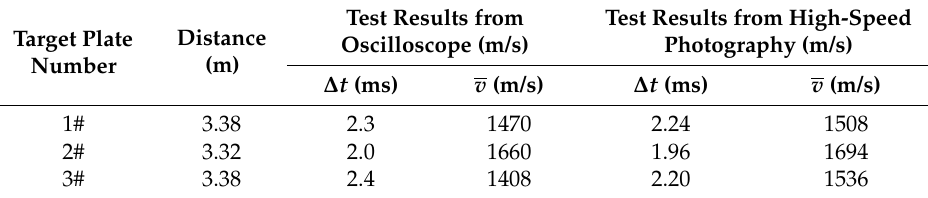
Table 4. Fragment velocity of D-120 ◦ experiment.